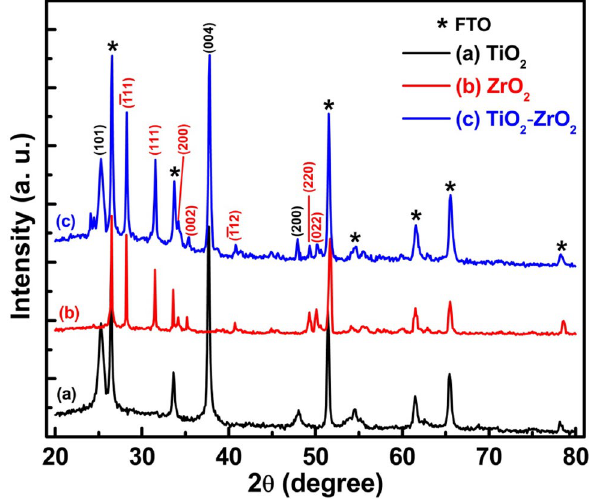
Fig. 1 XRD pattern of pristine TiO TiO 2 –ZrO 2 ( c ) films